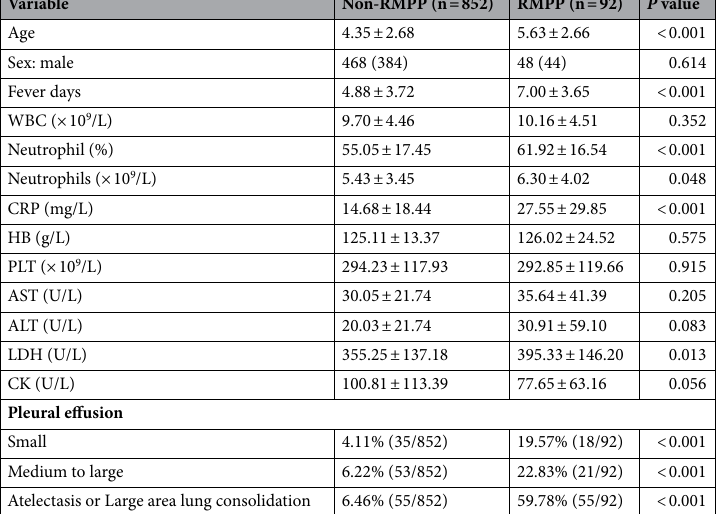
Table 5. Admission characteristics of children with Mycoplasma pneumoniae pneumonia in the prospective cohort according to their subsequent clinical outcome. Values are presented as mean ± SD. ALT alanine aminotransferase, AST aspartate aminotransferase, CK creatine kinase, CRP C-reactive protein, HB hemoglobin, LDH lactate dehydrogenase, PLT platelets, RMPP refractory M. pneumoniae pneumonia, WBC white blood cells.